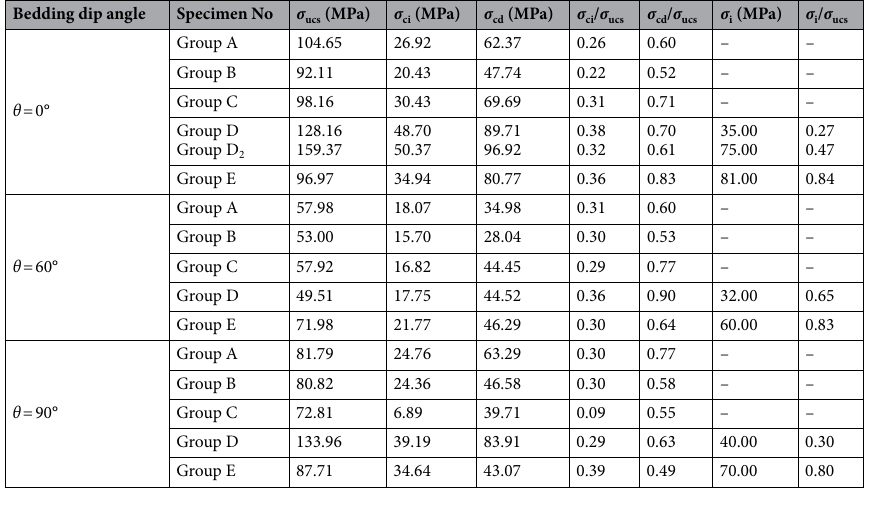
Table 2. Experimental results of shale specimens of groups A, B, C that were obtained from the constant strain rate experiments and corresponding results of shale specimens of groups D and E.